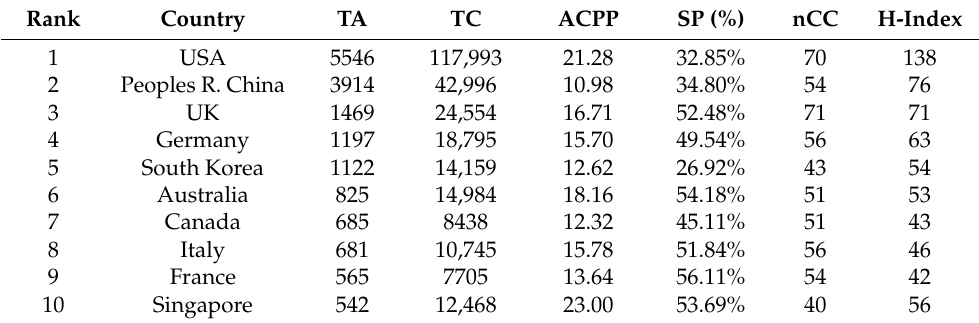
Table 1. The top 10 most productive countries and regions.